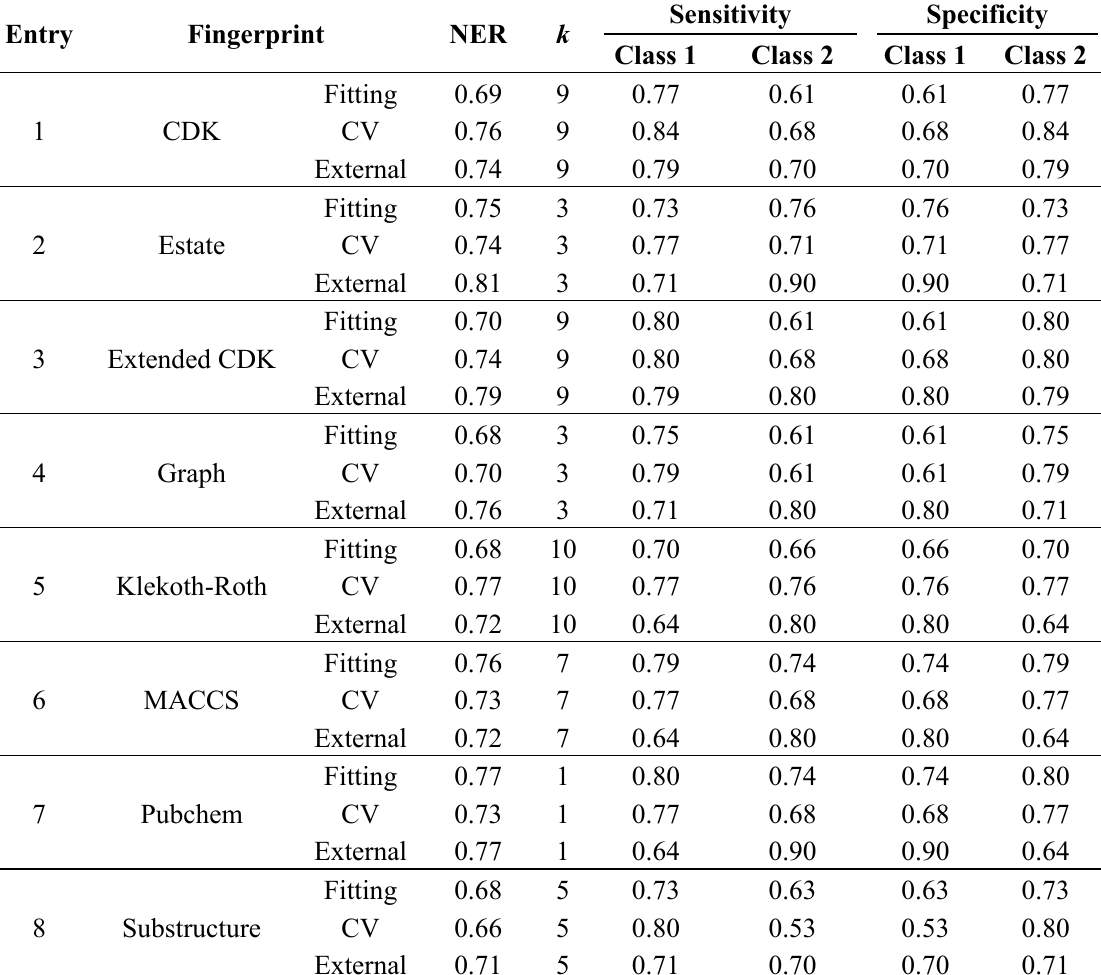
Table 1. Parameters of eight k -NN classification